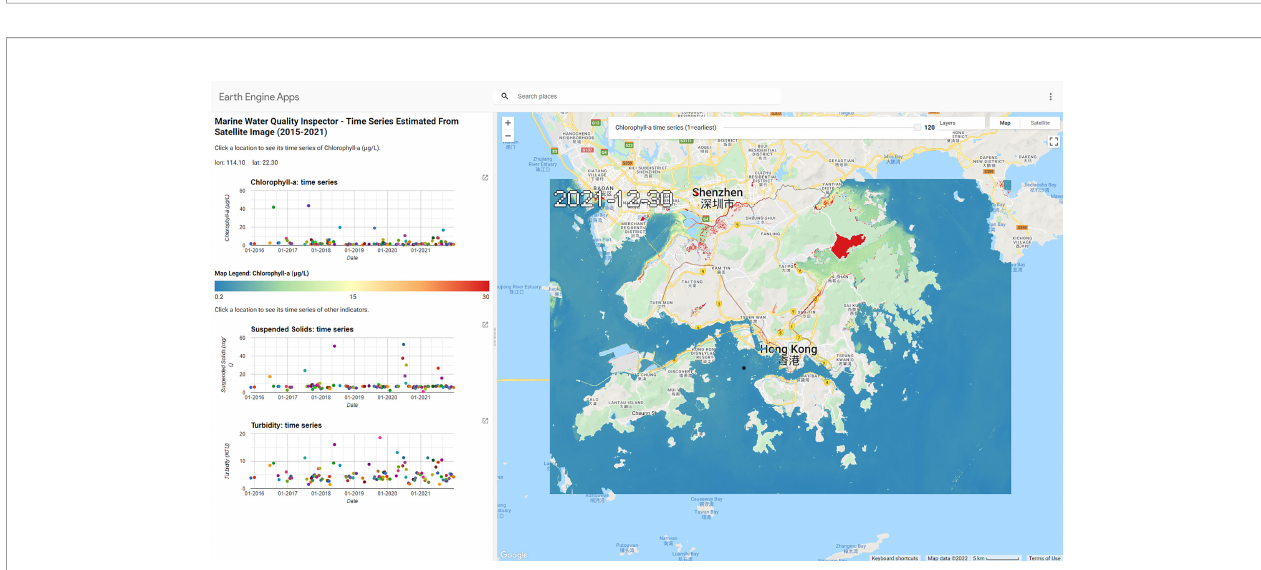
FIGURE 6 | (A) True color composite of Sentinel-2 image acquired on 13 th July 2020 and (B) the estimated chlorophyll-a (Chl-a) concentration map, overlaid with in situ data measured in the monitoring stations.